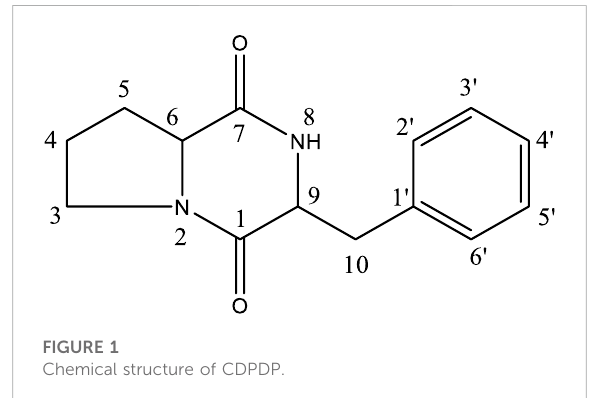
FIGURE 1 Chemical structure of